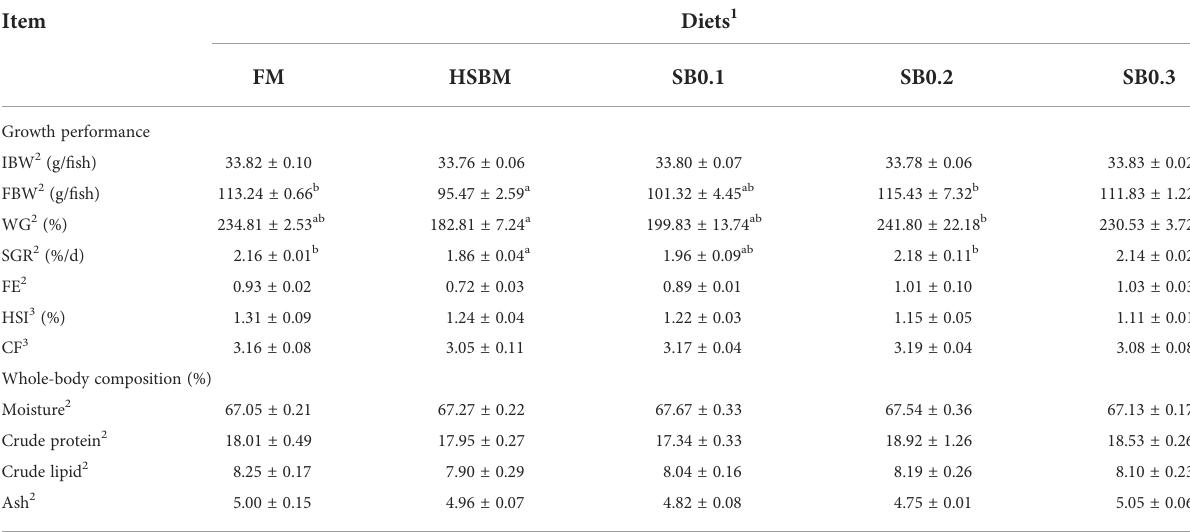
TABLE 3 Effects of sodium butyrate (SB) addition in high soybean meal (SBM) diets on growth performance and proximate composition of groupers in a 56-d feeding period.